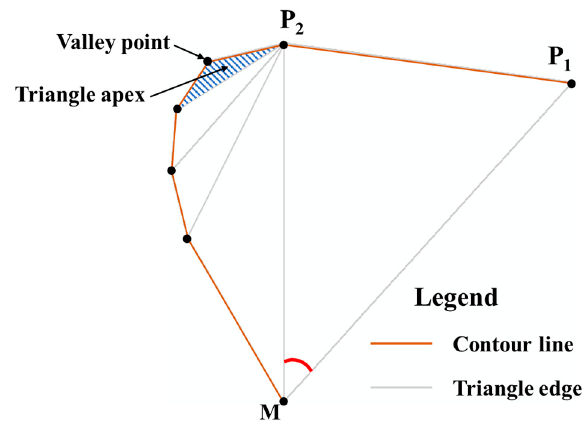
Figure 5. Valley point